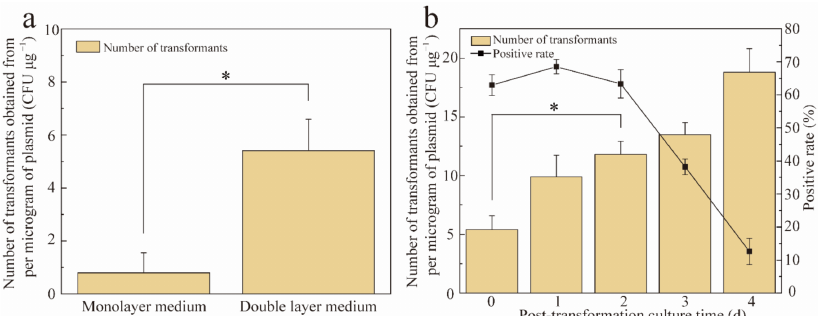
Figure 3. Different screening methods after transformation. ( a ) Culture methods for screening transformants; ( b ) post-transformation culture time. * p <